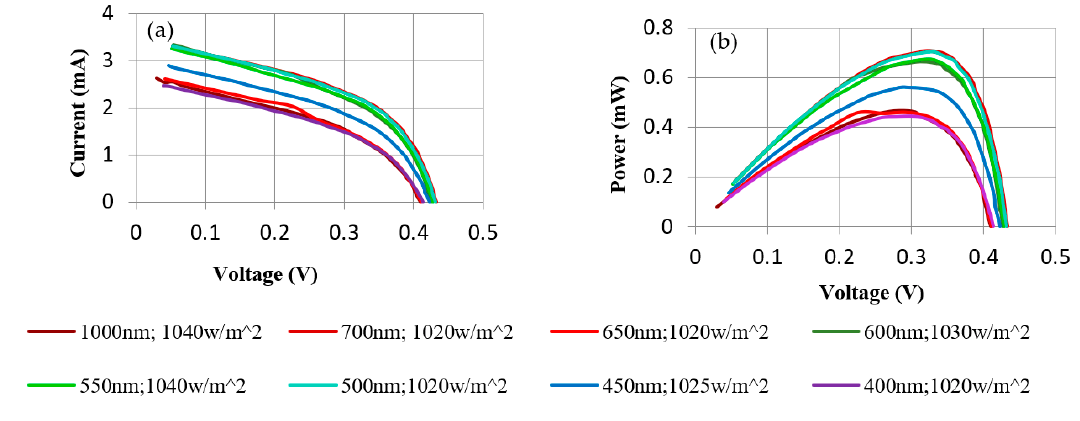
Figure 10. Tests performed with BP filters on August 21 2018 for the m-Si cell. ( a ) Voltage-current curves and ( b ) voltage-power curves. Table 6. Values of open circuit voltage, short-circuit current, maximum power, and respective variations for the tests with and without BP filters of m-Si cell for an irradiance of 1000 W / m 2 .